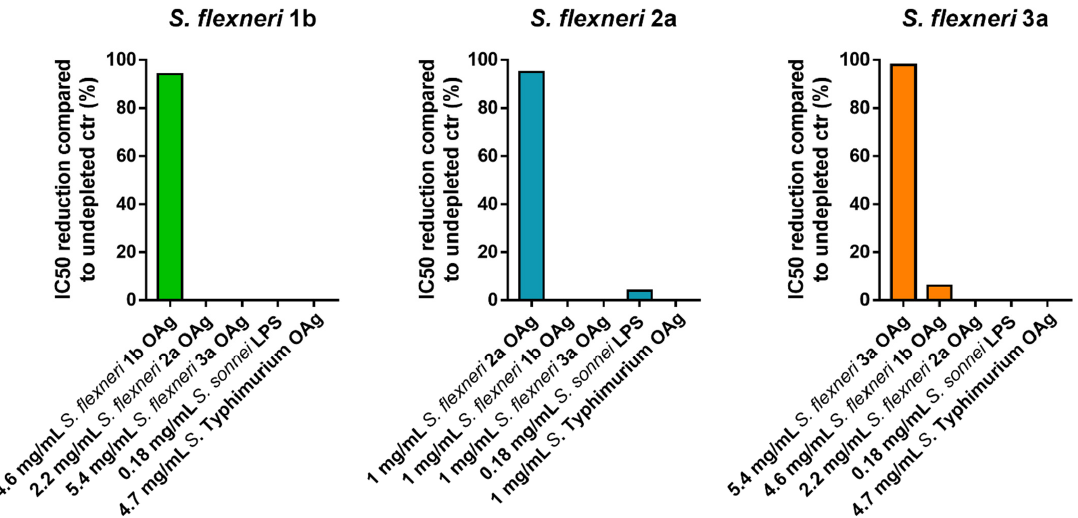
Figure 4. Specificity. IC50 reduction compared to undepleted control samples after incubation with homologous or heterologous competitors.